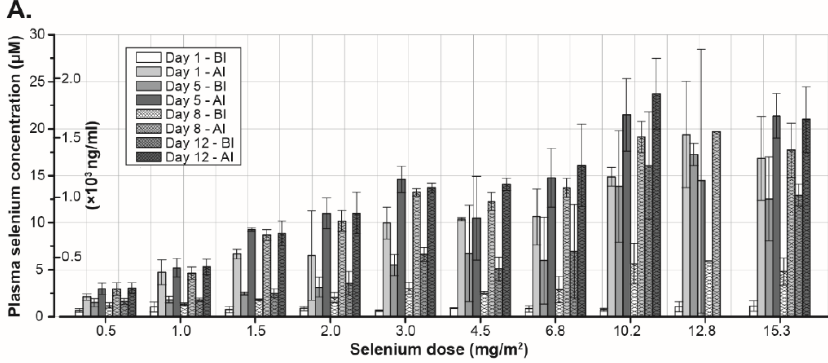
Figure 2. Routine blood parameters in patients during the course of the treatment as a measure of systemic toxicity. Abbreviations: WBC—white blood cell count; TC—thrombocytes count; AST—aspartate amino transferase; ALT—alanine amino transferase; ALP—alkaline phosphatase; and LDH—lactate dehydrogenase. 155 × 131mm (300 × 300